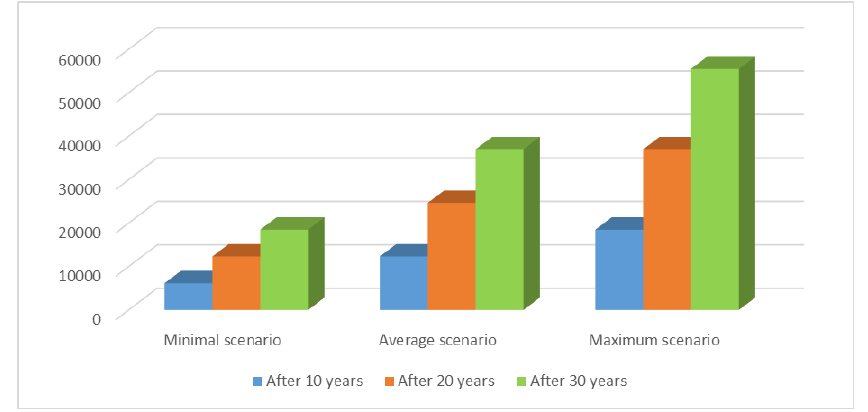
Figure 7. The evolution of the surface of the dwellings rehabilitated annually in each scenario (in thousand m 2 ). thousand m 2 ).